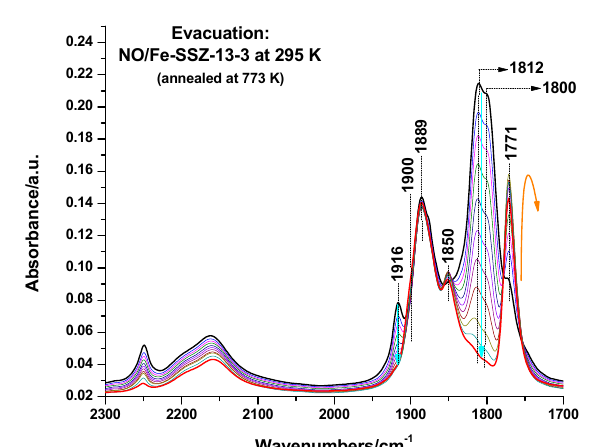
Figure 11. Selected IR spectra collected during the step-wise adsorption of NO on an annealed (773 K) Fe/SSZ-13 (Si/Al = 12, Fe loading = 0.63 wt%) sample at 295 K: ( a ) adsorption and ( b ) desorption. (The inset in panel a highlights the IR spectra recorded at the lowest NO dosages). Reprinted with permission from [29]. Copyright © 2016 by the Owner Societies.